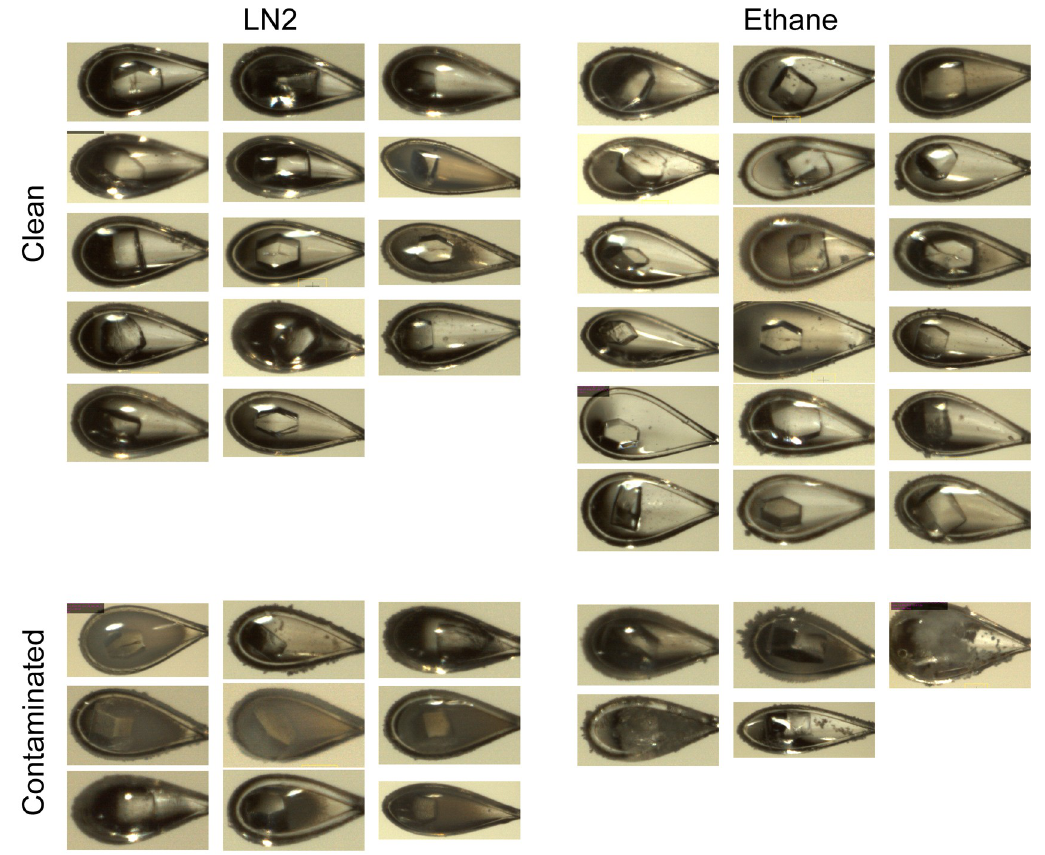
Fig 3. Images of HEWL crystals. Crystals flash-cooled in LN2 ( left ) and ethane ( right ). The top images represent the clean fraction of crystals whereas the images below display samples severely contaminated with ice.